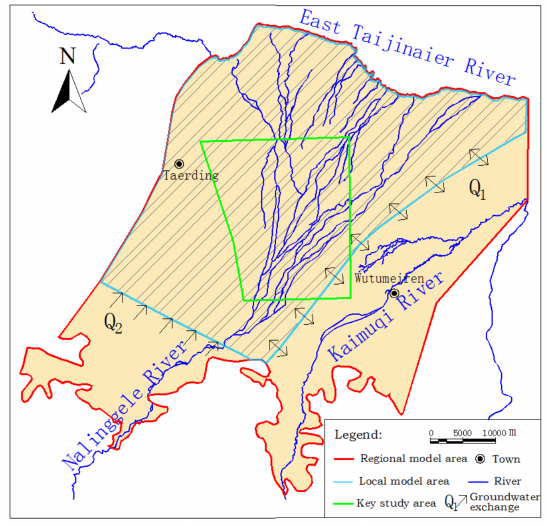
Figure 4. Sketch map of nested model